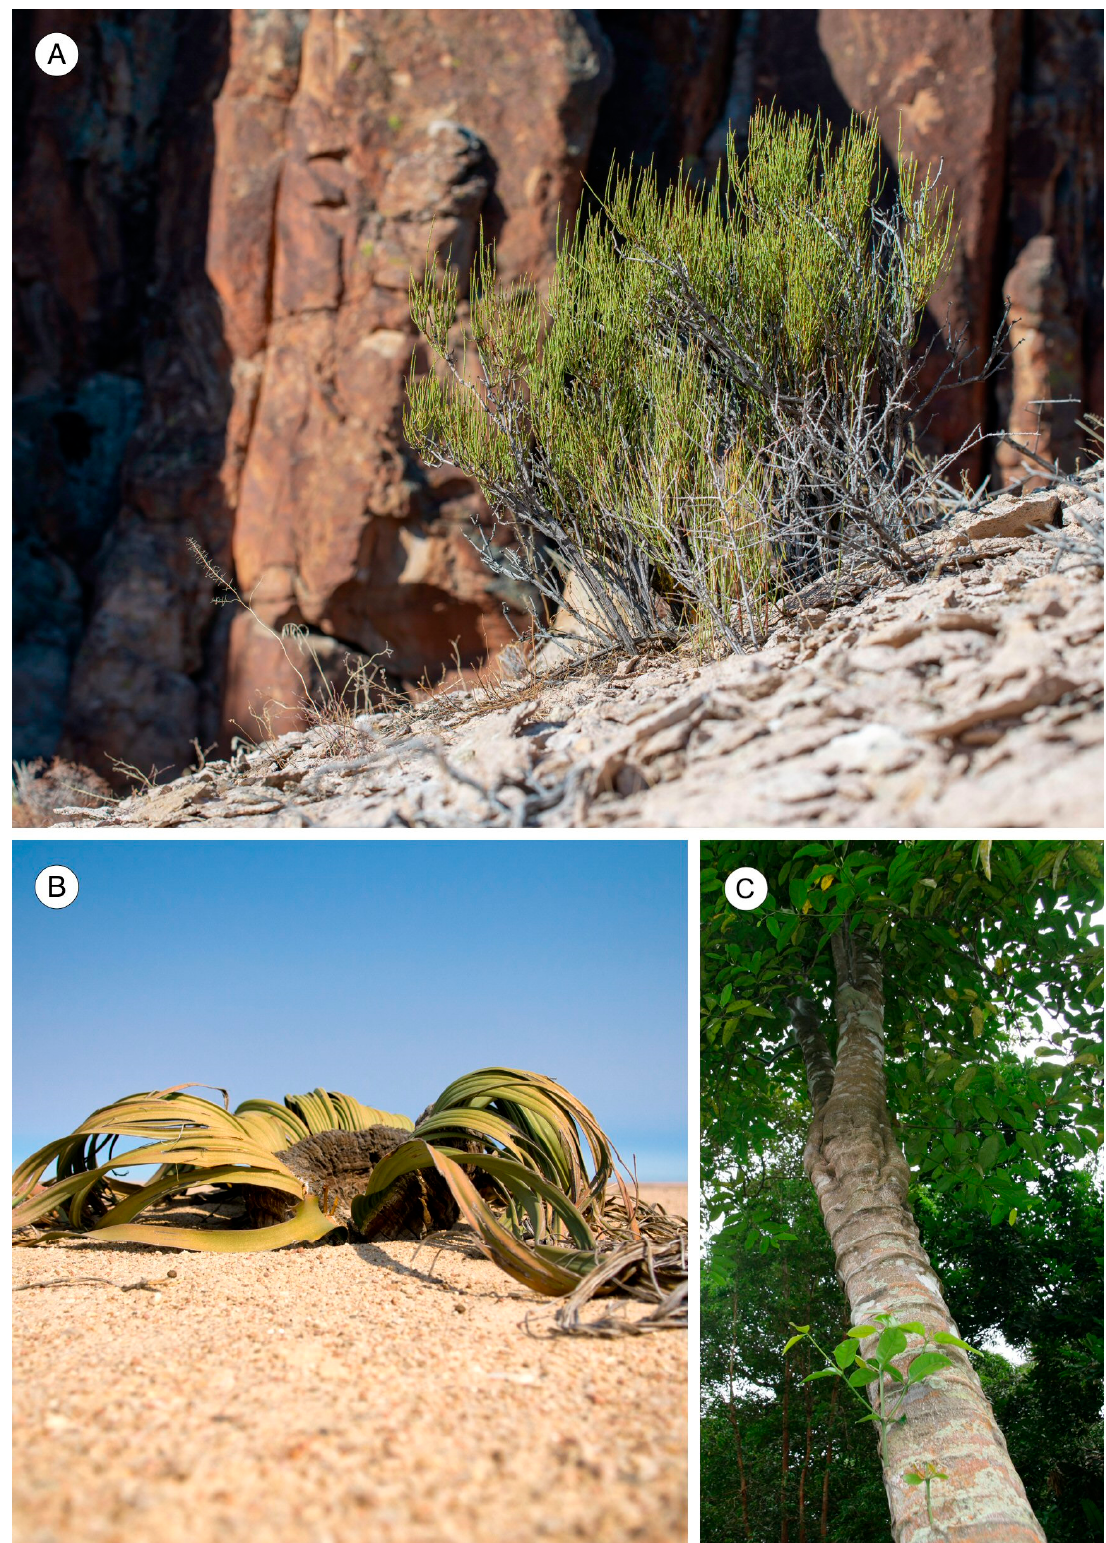
Figure 4. Non-coniferous gymnosperms. ( A ) Ephedra viridis Coville; ( B ) Welwitschia mirabilis Hook. f.; ( C ) Gnetum gnemon L.